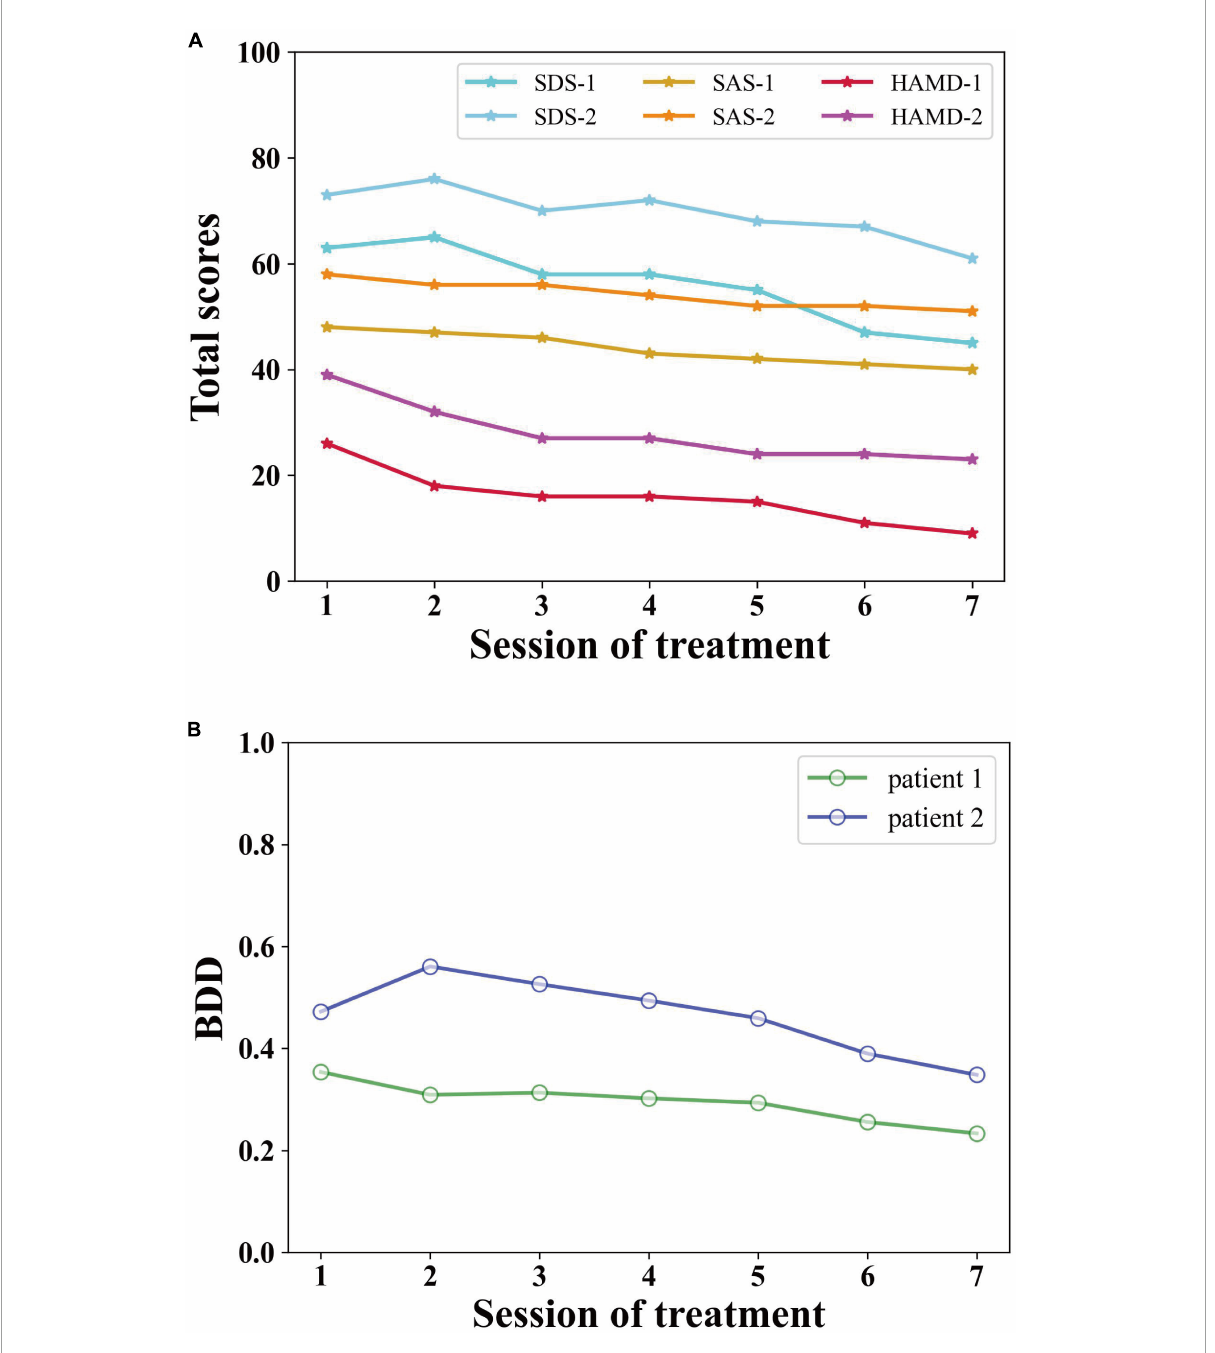
FIGURE2 The total scores of (A) SDS, SAS, HAMD, and (B) BDD of the two selected patients.